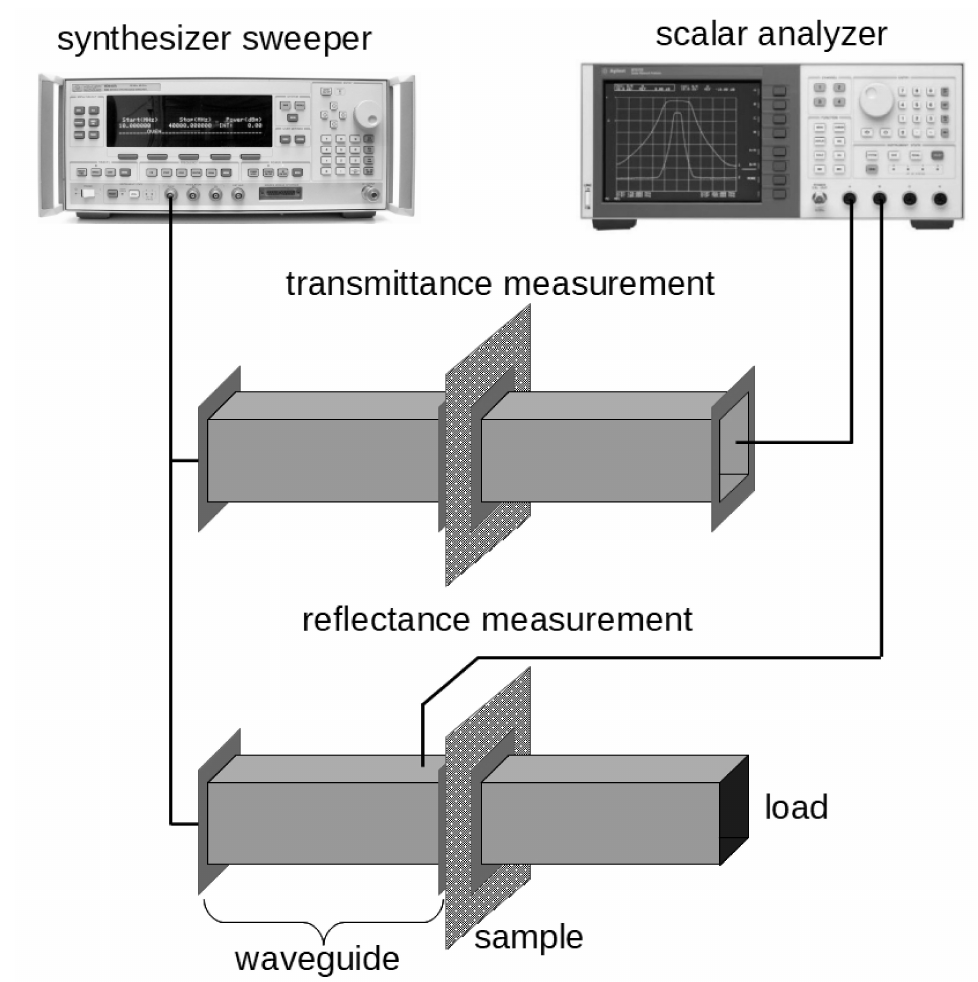
Figure 2. Stand for the independent determination of the transmittance and reflectance of the